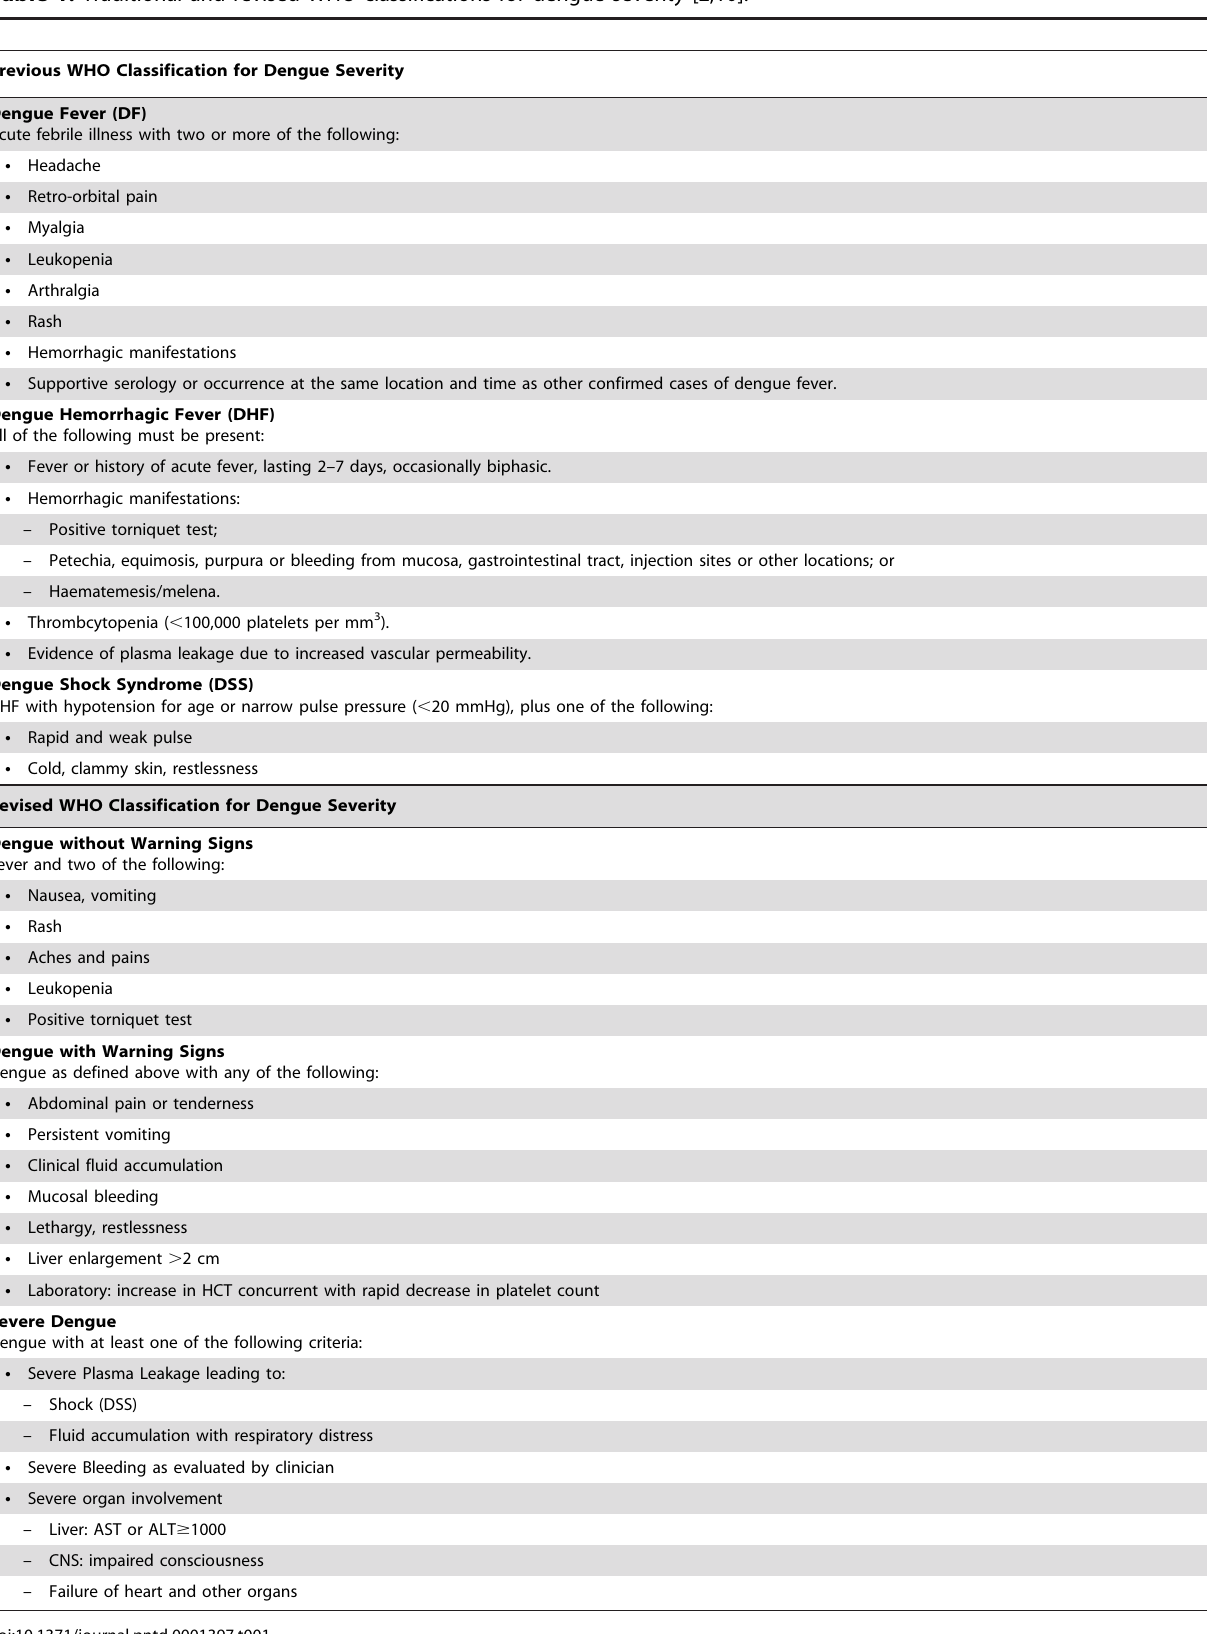
Table 1. Traditional and revised WHO classifications for dengue severity [2,10].